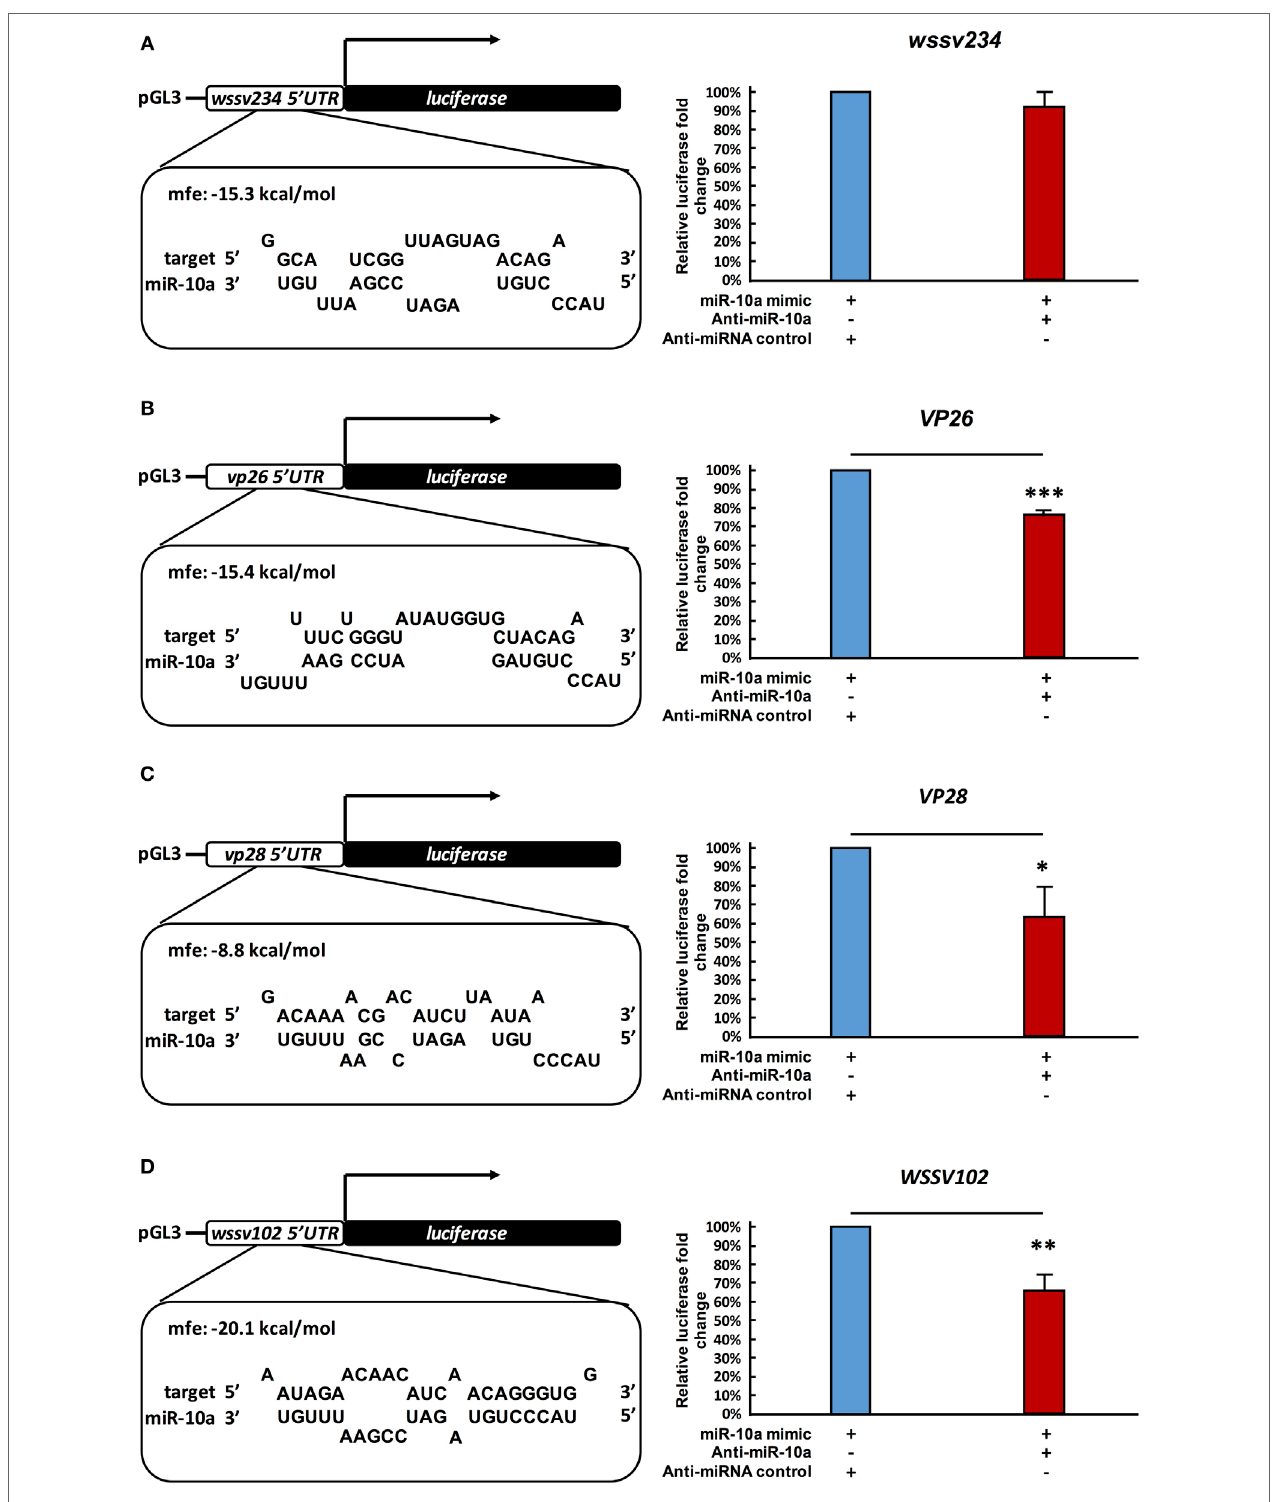
FigUre 3 | Suppression of miR-10a significantly reduces the expression of at least three WSSV genes. (a–D) Luciferase reporter assay for wssv234 , vp26 , vp28 , and wssv102 , respectively. Sf9 cells were transfected as indicated with the respective ie1 /pGL3/5 ′ -UTR firefly luciferase expression construct (500 ng) plus miR-10a mimic (32 pmol), along with either anti-miR-10a (32 pmol) or the anti-miRNA control (32 pmol). At 48 h post-transfection, firefly luciferase signals were normalized relative to those of the Renilla luciferase internal control, and data are shown relative to the anti-miRNA control (set to 100%). Data represent mean ± SD from three independent experiments; * p < 0.05, ** p < 0.01, and *** p < 0.005 by Student’s t